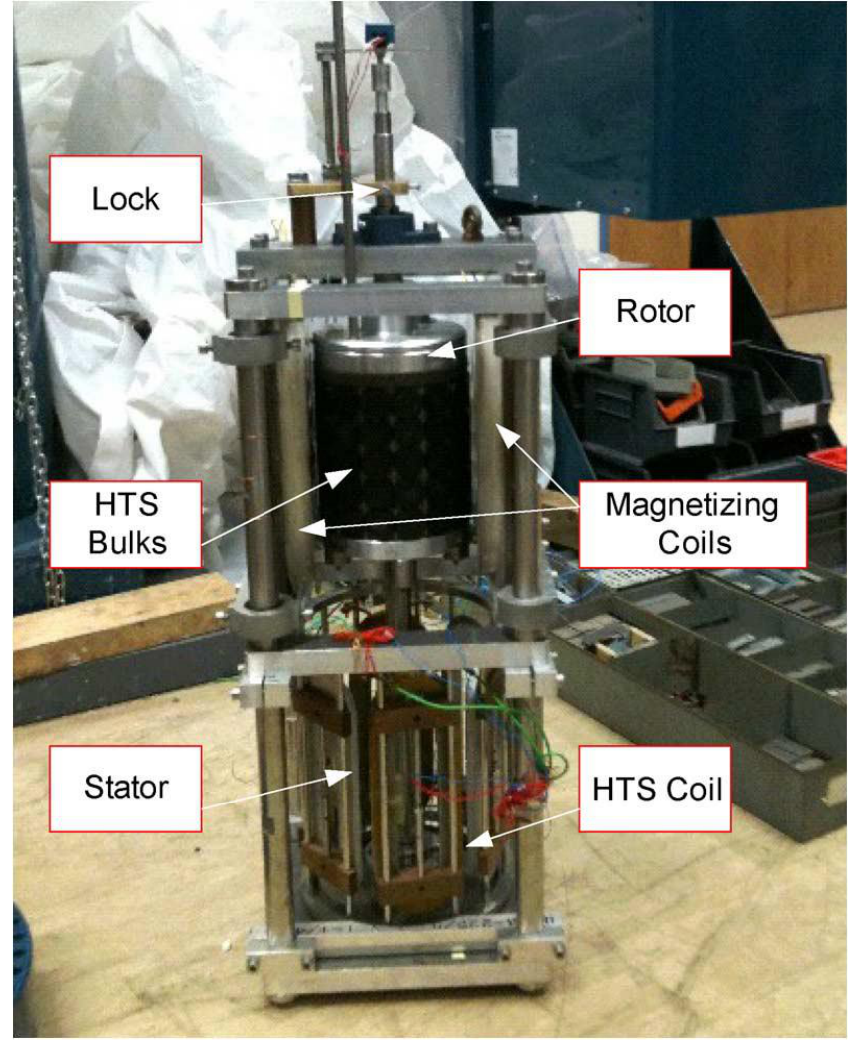
Figure 6. HTS bulk motor designed and built by Dr Coombs et al. [34].